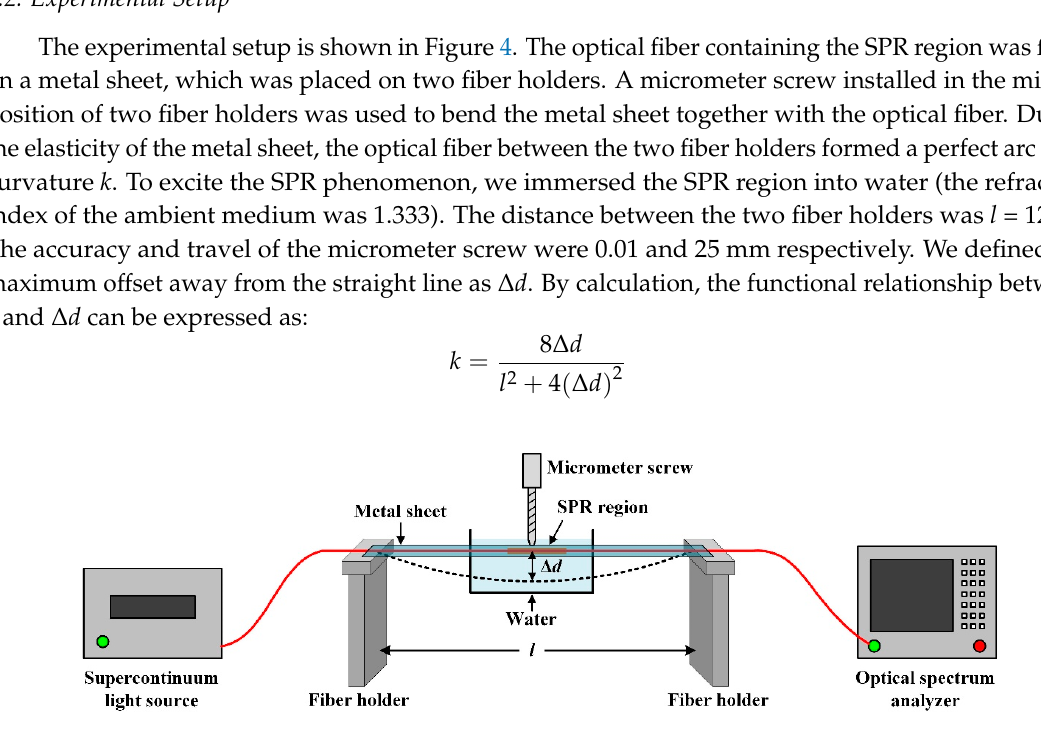
Figure 4. The sketch diagram of the fiber SPR bending sensor experiment system.